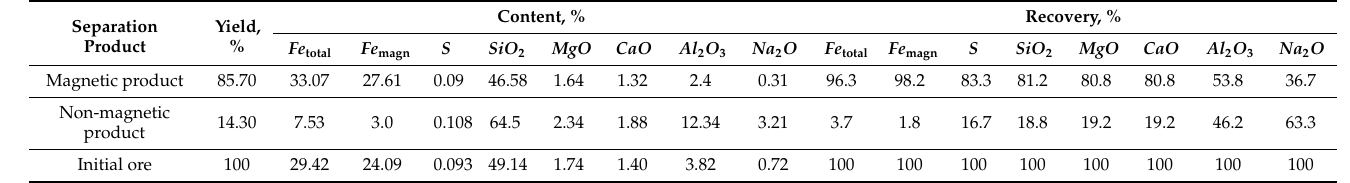
Table 5. Results of dry magnetic separation of an iron ore sample, Korpangskoe deposit.